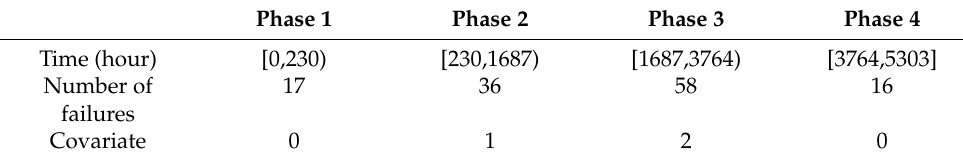
Table 3. Description of the dataset.